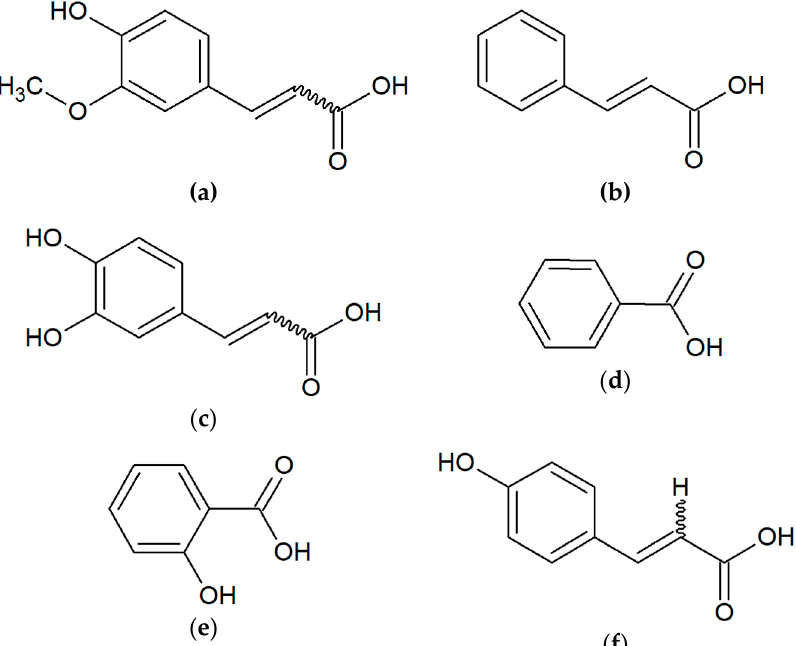
Figure 3. Aromatic acids present in propolis: ( a ) ferulic acid; ( b ) cinnamic acid; ( c ) caffeic acid; ( d ) benzoic acid; ( e ) salicylic acid; ( f ) p -cumaric acid.